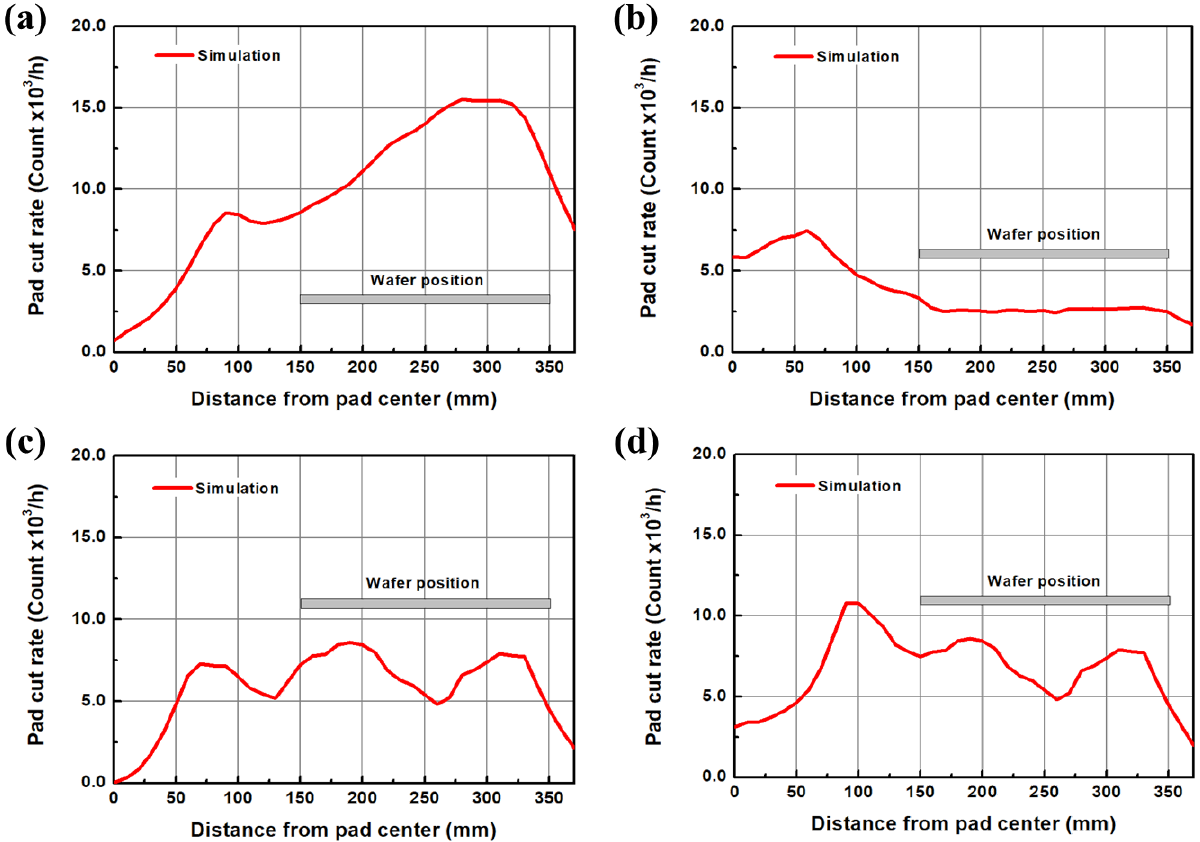
Figure 7. Simulation result of pad cut rate distribution: ( a ) Case I (reference), ( b ) Case II, ( c ) Case III, and ( d ) Case IV.